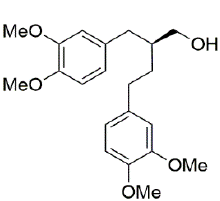
Molecules 2019 , 24 , x FOR PEER REVIEW